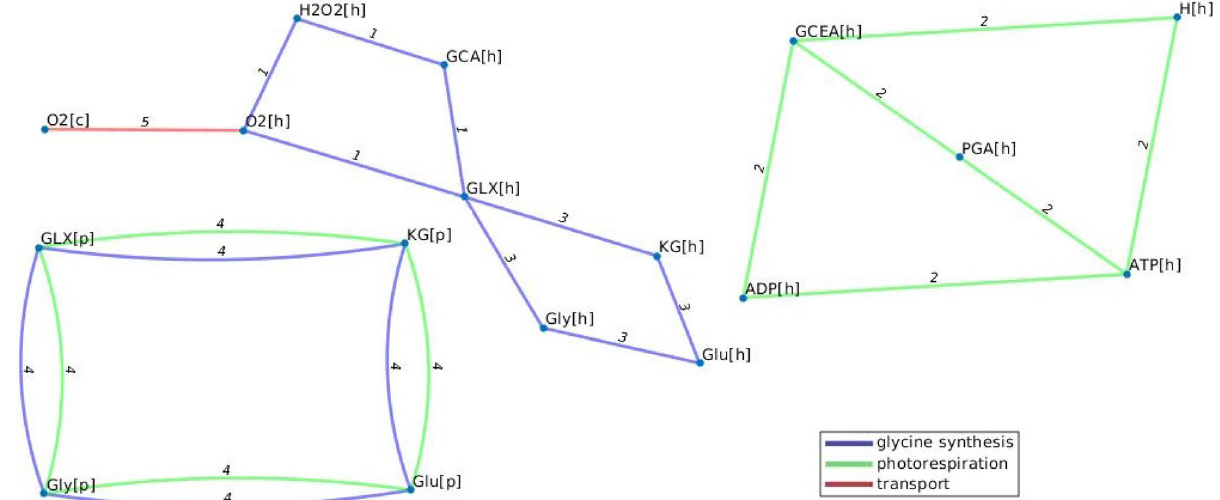
Figure 7. Flux trade-off in the model of A. thaliana. The selected trade-off includes reactions from three metabolic subsystems, represented in different colours. The figure shows a trade-off between five reactions. The following reactions are included: (1) Glu:GLX aminotransferase, (2) GCEA kinase, (3) GCA oxidase, (4) Glu:GLX oxidase, aminotransferase and (5) O2 diffusion reaction. The considered metabolites include H: H + / proton, O2: oxygen, ADP: Adenosine diphosphate, ATP: Adenosine triphosphate, PGA: 3-Phosphoglycerate, GCA: Glycolate, GLX: Glyoxylate, Glu: Glutamate, Gly: Glycine, KG: alpha-Ketoglutarate, 2-Oxoglutarate, GCEA: Glycerate, KG: alpha-Ketoglutarate, 2-Oxoglutarate, H2O2: Hydrogen peroxide.[c] corresponds to cytoplasm, [p] :periplasm, and [h]: